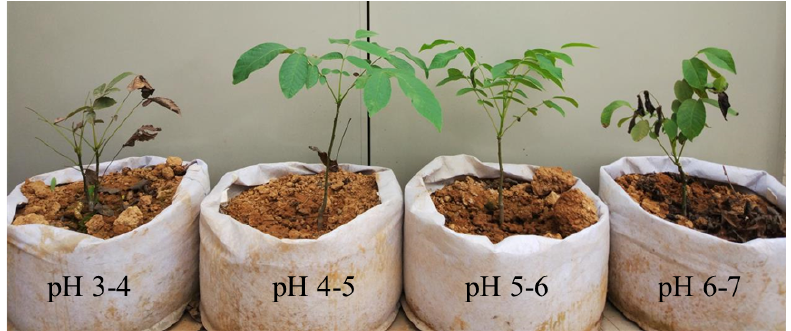
Figure 1. Iron walnut seedlings subjected to a series of soils of differing acidity.